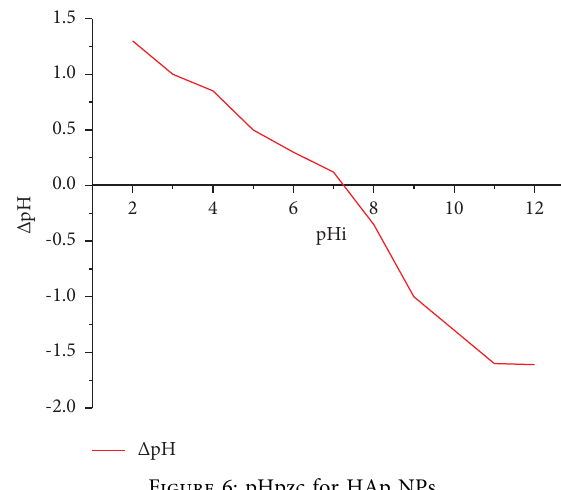
Figure 6: pHpzc for HAp